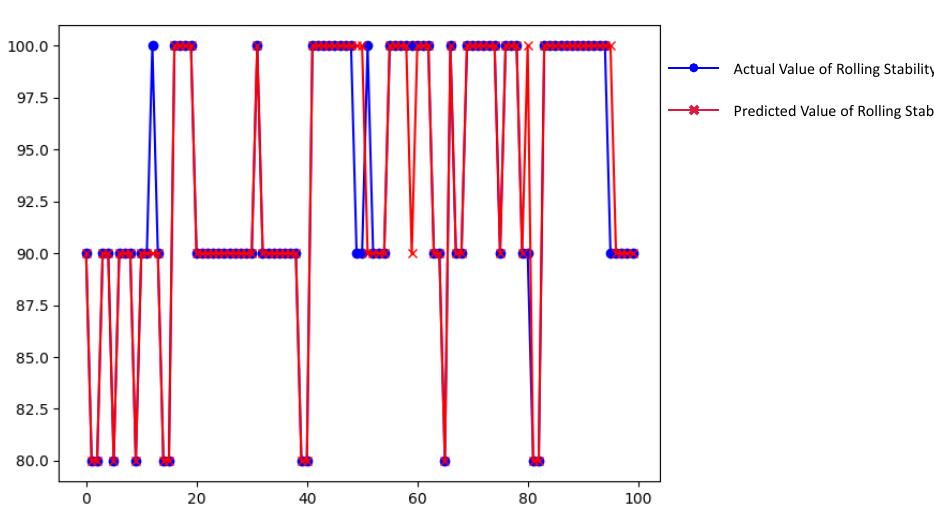
Figure 4. MRTRG00201_1276_3 Test set